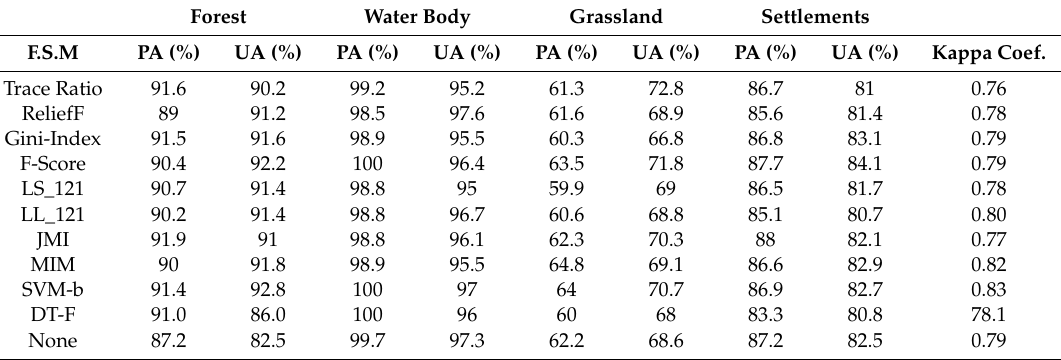
Table 5. Classification accuracies of other classes using optimal feature subsets yielded by investigated feature selection methods for the second training set.